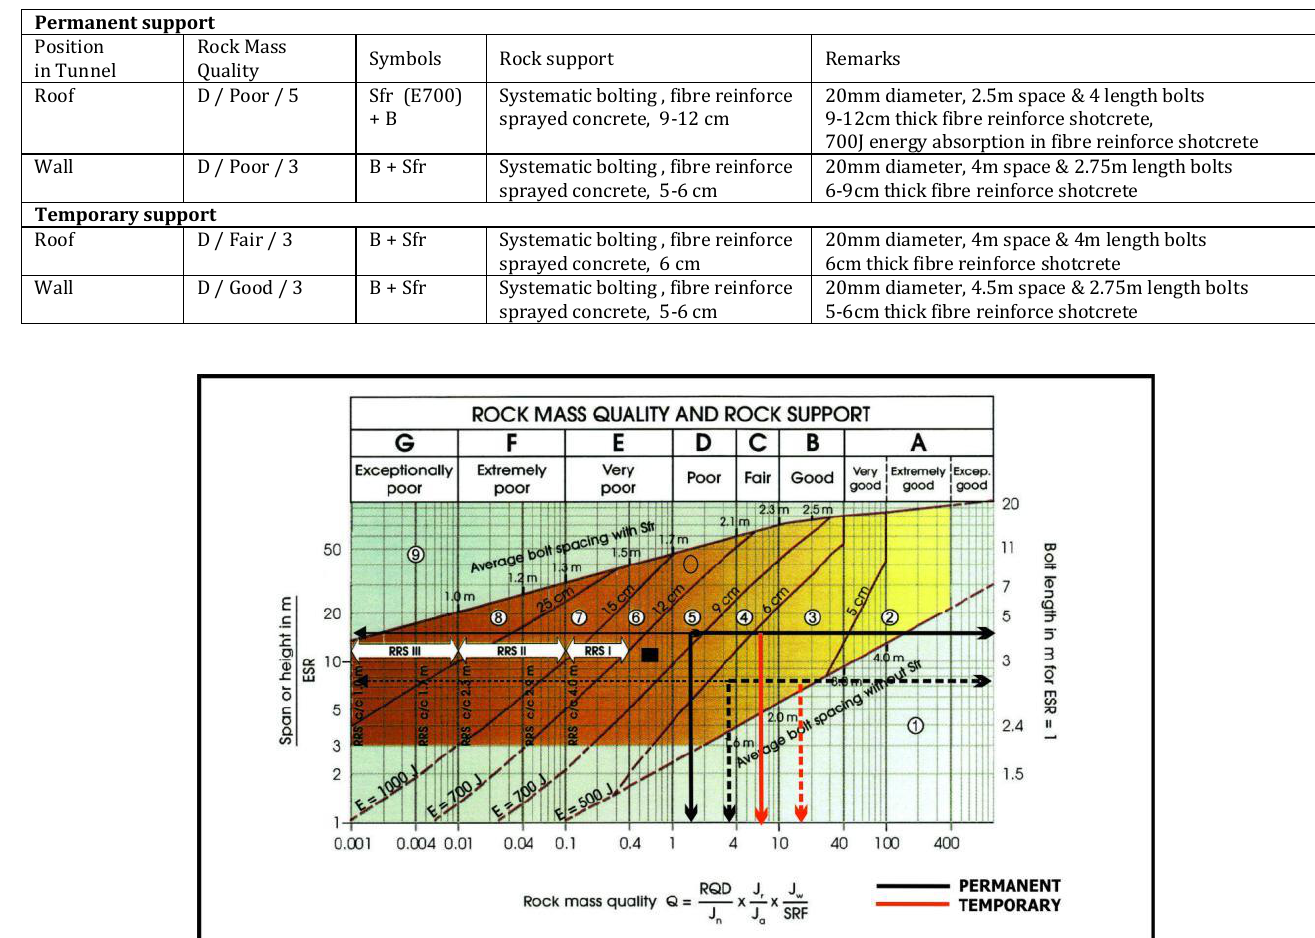
Table 2: Summary of the result of permanent and temporary support design requirement of tunnel roof and wall.